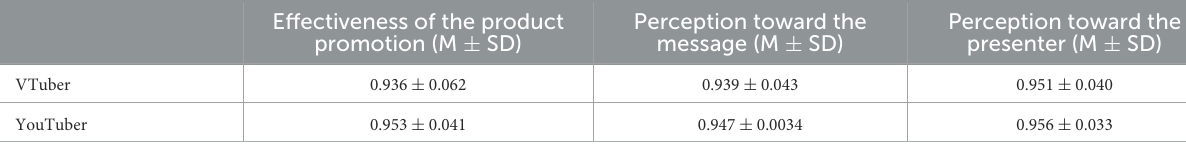
TABLE 3 Cosine similarity between the two domains.